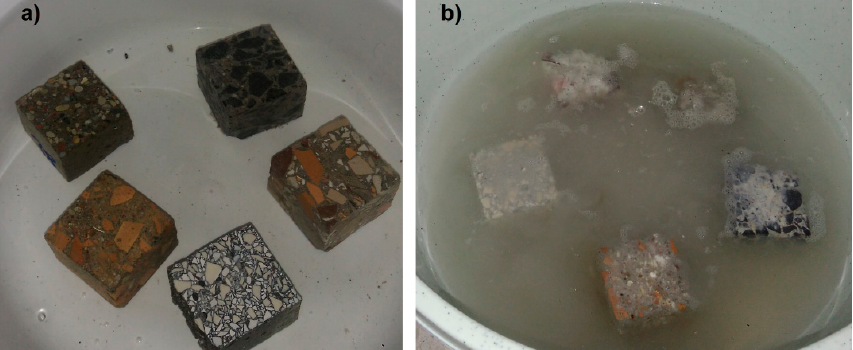
Figure 4. Samples of the tested composites on day 90 of the experiment ( a ) in water, and ( b ) in solution.